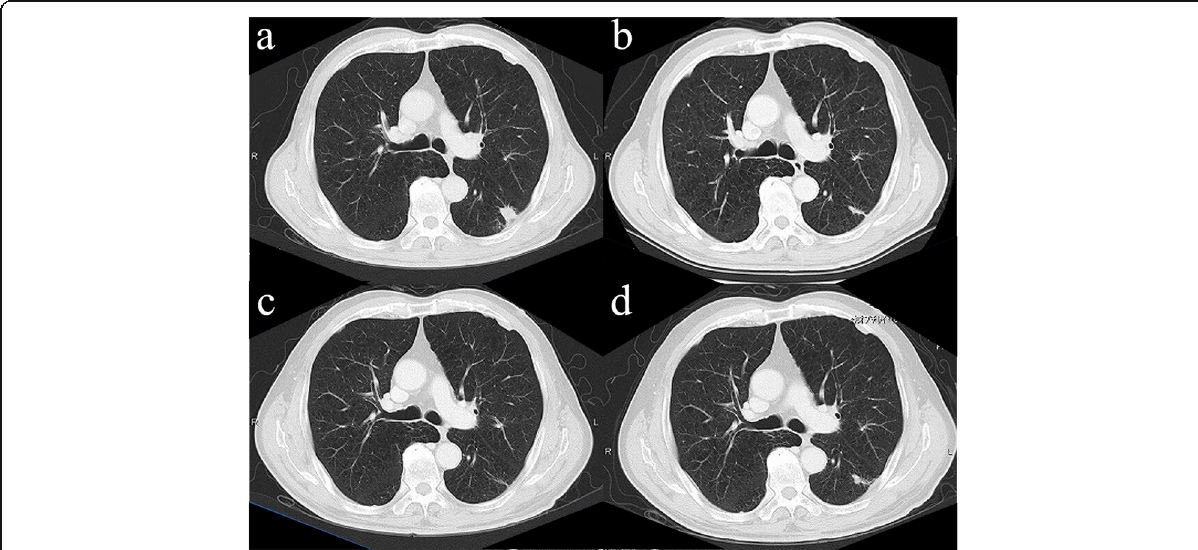
Fig. 1 Computed tomography (CT). a Chest CT showed a well-circumscribed, 1.6-cm mass in the S6 segment of the left lower lobe. b CT performed before chemotherapy and 2 months after left adrenalectomy showed spontaneous regression of lung lesions. c After chemotherapy,